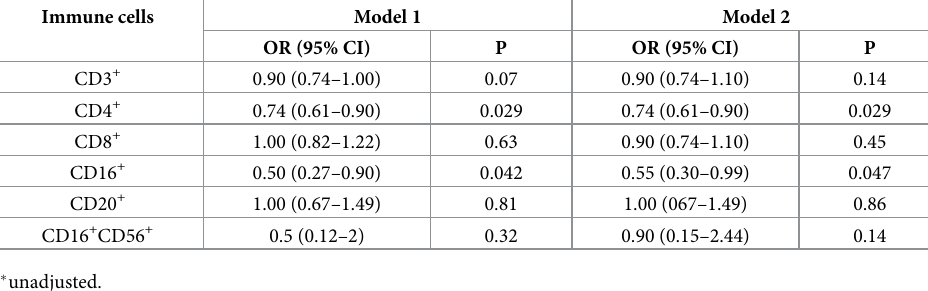
Table 5. The odds of death affected by immune cells in patients with COVID-19. Immune cells